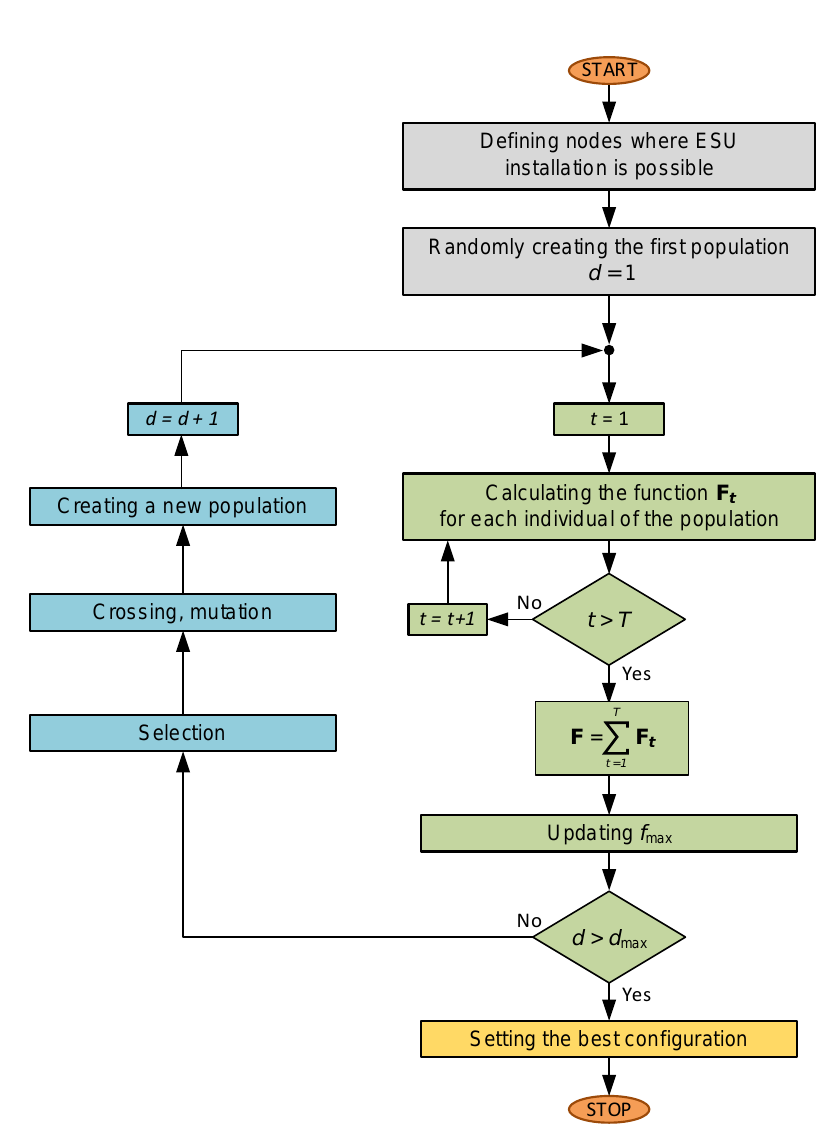
Figure 1. A diagram of the genetic algorithm used to select the location of energy storage units (ESU) in the distribution grid (for symbols see Appendix A).